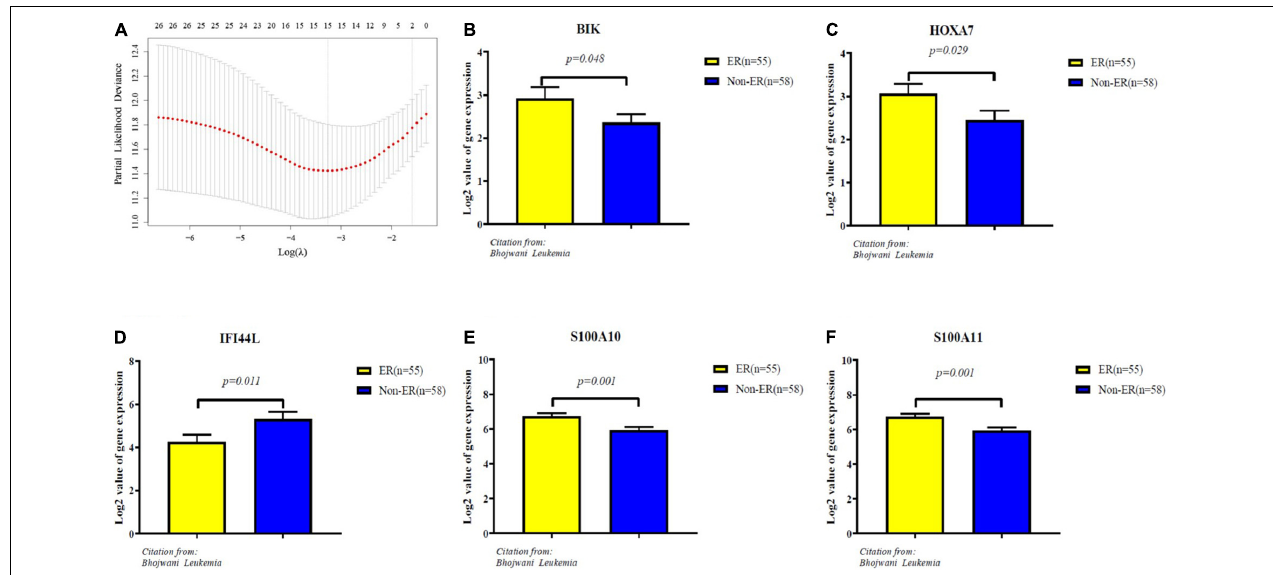
FIGURE 4 | Identification of five significantly prognostic genes related to early relapse. (A) LASSO regression with tenfold cross-validation obtained 15 prognostic genes using optimal lambda value. (B–F) The expression level of prognostic genes between ER and no-ER groups. ER means early relapse, no-ER means no early relapse.